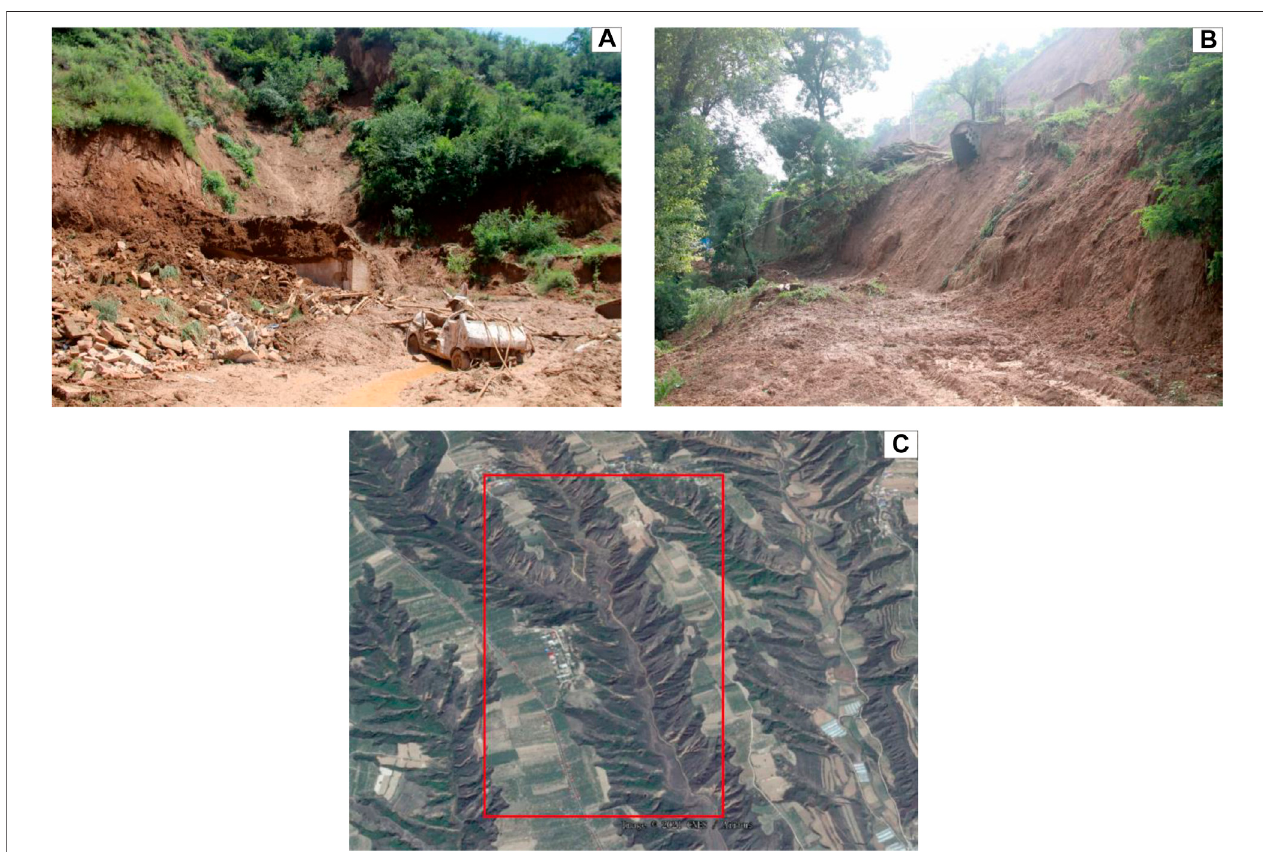
FIGURE 2 | Some pictures and images after the debris fl ow event: (A) a small vehicle submerged by the mixture of soil and rocks, (B) a house damaged by the fl owing material in the channel, and (C) the remote sensing image of the channel in April 2014 from Google Earth (access at August 10). The red rectangle shows the location of the